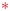
Discretized schematics of a mathematical model.(A) A schematic of glioma cell infiltration through narrow intercellular space (IS) between normal resident glial cells in the direction (green arrow) of a chemotactic source (red star; *). A glioma cell is described by two elastic closed curves, representing the outer cell boundary (blue solid lines) and the boundary of the nucleus (red solid lines; ‘N’). The boundaries consist of elastic springs connected by nodes. Resident normal cells (black dashed lines) are treated in a similar fashion but without the nucleus. Normal cells are assumed to be relaxed and passively respond to biochemical and biomechanical stimuli, in other words, cells are tethered in the tissue (red lines and box). (B) During the elongation step, active force is generated at the front of the cell body and adhesion onto the substrate is formed at the rear of the cell. (C) In the retraction step, the glioma cell pulls both cell body and nucleus forward by forming attachment at the front and releasing the attachment of the rear edge.